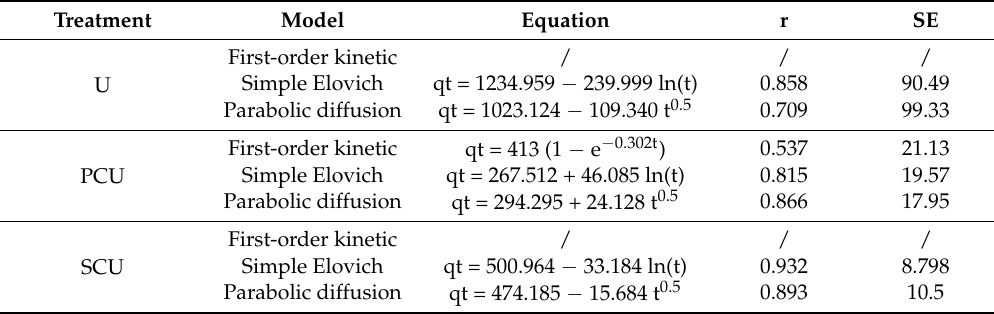
Table 4. Dynamic characteristics of NH 4+ in